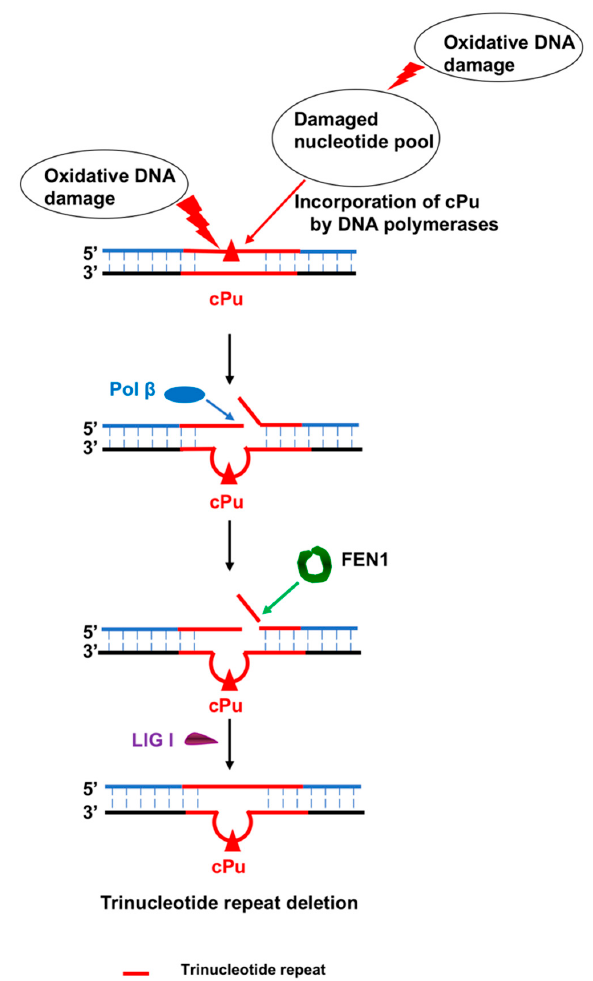
Figure 9. A cdA located at DNA repeat sequences induces repeat instability through pol β bypass of β : DNA polymerase β ; LIG I: DNA ligase I; FEN1: flap endonuclease a loop structure. Pol β : DNA polymerase β ; LIG I: DNA ligase I; FEN1: flap endonuclease 1. loop structure. Pol